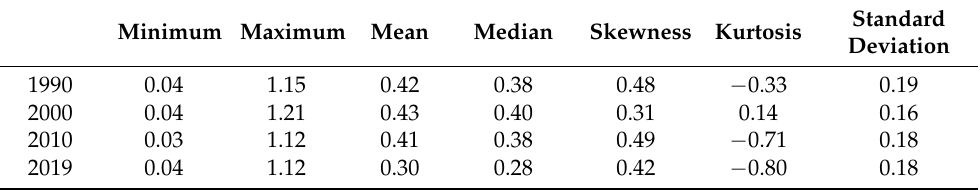
Table 2. Description statistics of PC1.